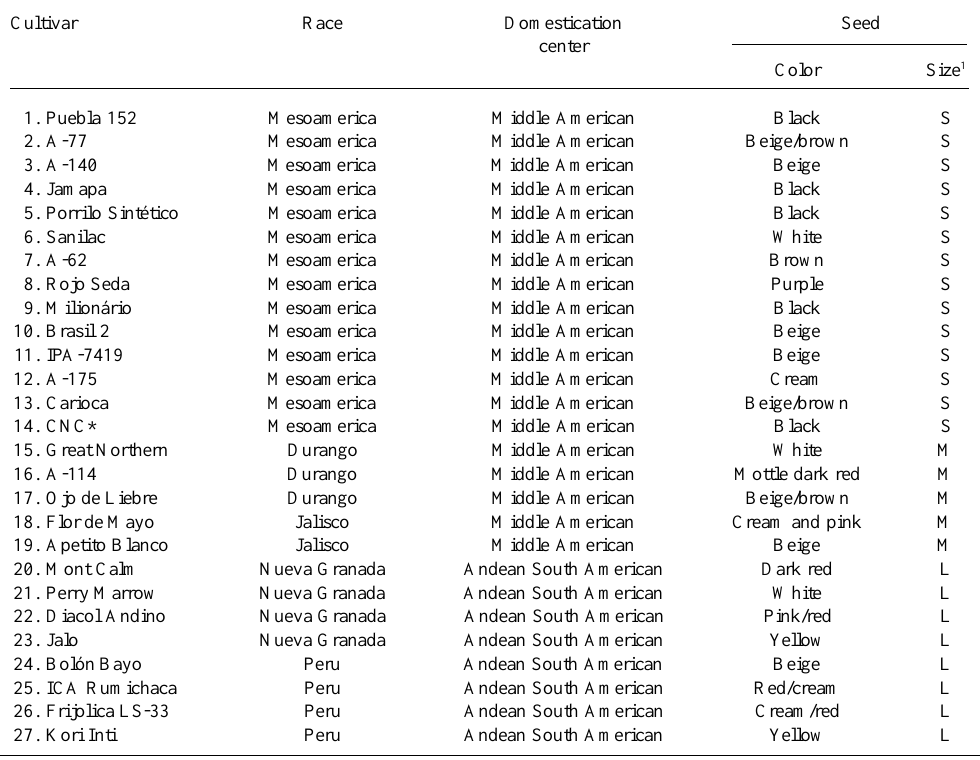
Table I - Common bean cultivars, their races, domestication centers and seed characteristics.